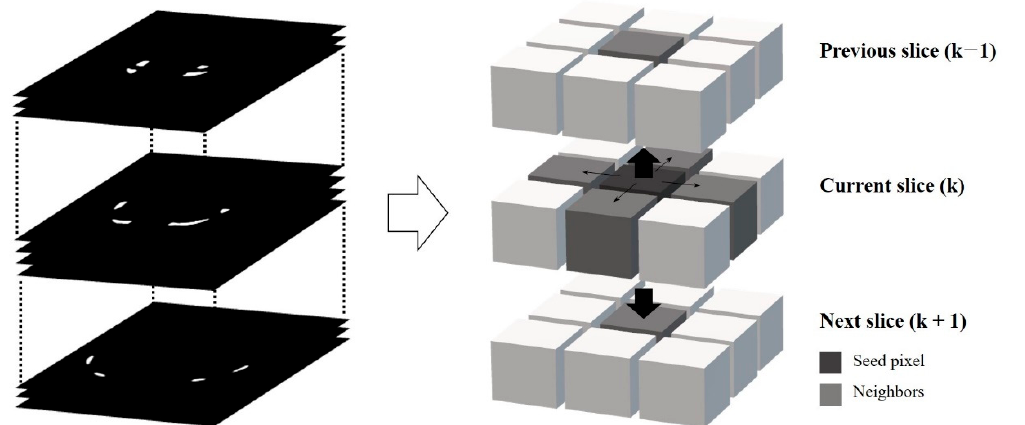
Figure 4. The principle of 3D region growing using 6-neighborhood .